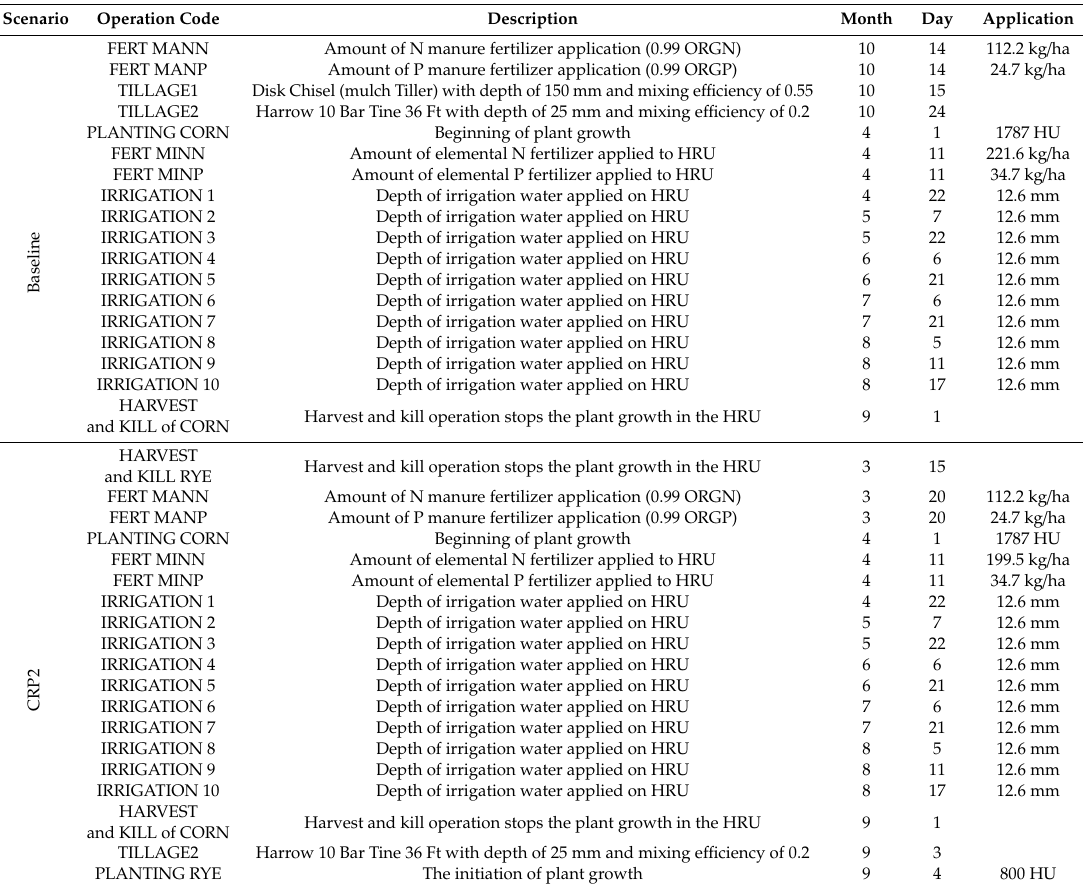
Table 2. Example of management operations for irrigated corn (grid-cell 403, HRU 5) as defined in SWAT for baseline and scenario CRP2 (see Section